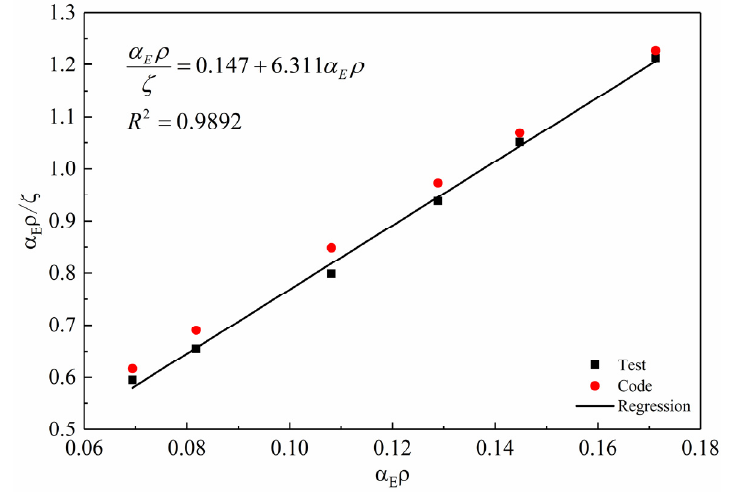
Figure 10. Regression of the elastic–plastic resisting moment coefficient.